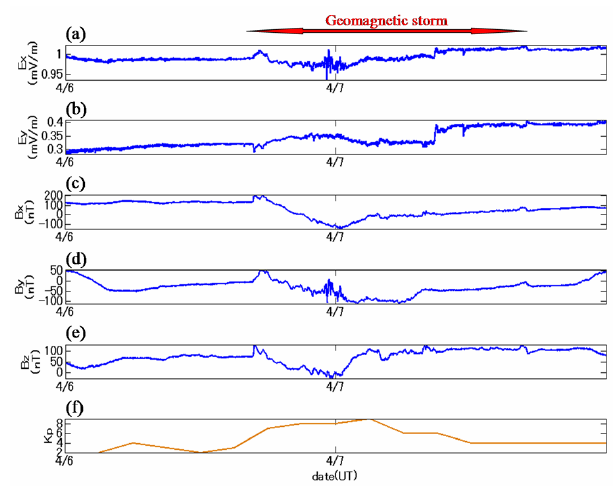
Fig. 3. An example of ULF electromagnetic variation associated with the DC-driven train noise. (a) Ex component (mVm − 1 ), (b) Ey component (mVm − 1 ), (c) Bx component (nT), (d) By com- ponent (nT), and (e) Bz component